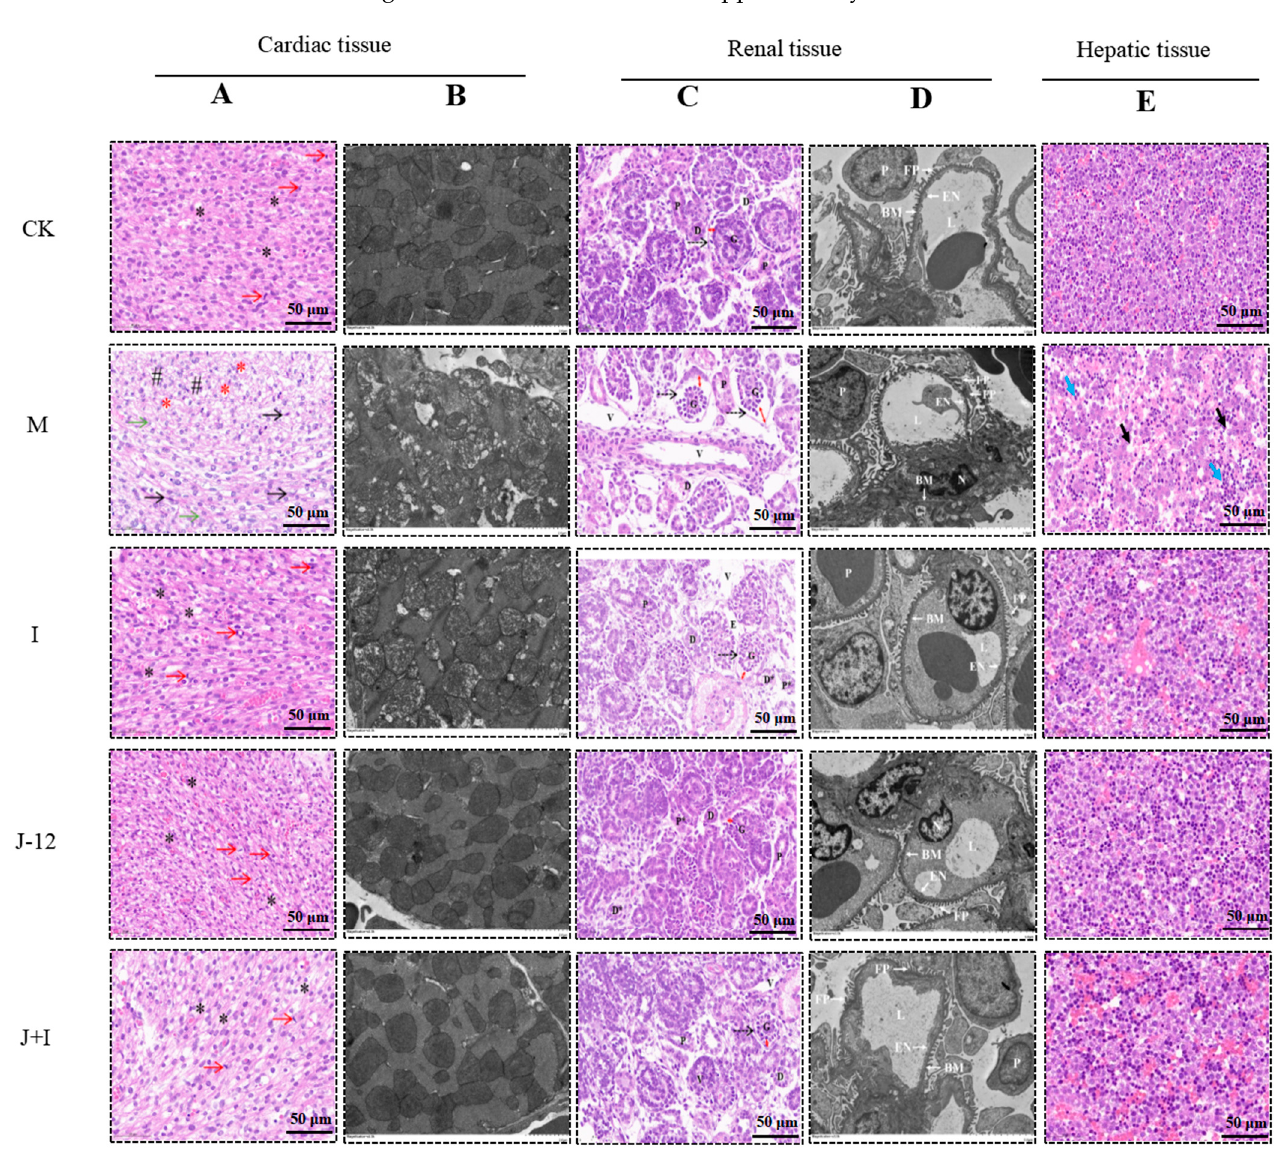
Figure 5. J-12 reduced cardiac, renal, and hepatic tissue damage of fetuses. ( A ) H&E staining in cardiac sections. Mitosis is indicated by the red arrows, and transverse band of cardiomyocytes is indicated by “*”. Cellular nuclear sequestration is indicated by the black arrow, cytoplasmic hydro- graphic changes is indicated by “#”, chromatin hydrolysis of the nucleus is indicated by the green arrows, and cytoplasmic vacuolization is indicated by the red “*”. Magnification = ×400. Scale bar: 50 μ m. ( B ) Transmission electron microscopy (TEM) in cardiac sections. Magnification = ×5.0 k. Scale bar: 2 μ m. ( C ) H&E staining in renal sections. Renal capsule is indicated by the dashed arrow, eryth- rocyte space is indicated by the double arrow. Glomerular (G), proximal convoluted tubules (P/P*), distal convoluted tubules (D/D*), tubular vacuole (V). Magnification = ×400. Scale bar: 50 μ m. ( D ) Transmission electron microscopy (TEM) in renal sections. Glomerular capillary lumen (L), endo- thelial cell with euchromatic nucleus (N), fenestrated layer (EN), basement membrane (BM), podo- cyte (P), foot processes (FP). Magnification = ×3.0 k. Scale bar: 5 μ m. ( E ) H&E staining in hepatic sections. Hepatic cord rupture is indicated by the black arrow, and relative increase of hematopoi- etic cells is indicated by the blue arrow. CK: control group, rats fed a standard diet. M: model group, rats fed an HFD and administered a single STZ injection prior to pregnancy and then fed a standard diet during pregnancy. I: insulin group, rats fed an HFD and administered a single STZ injection prior to pregnancy and then fed a standard diet and injected the insulin and during pregnancy. J- 12: J-12 group, rats fed an HFD and administered a single STZ injection prior to pregnancy and then fed a standard diet during pregnancy. Rats administered the J-12 suspension (1 × 10 9 CFU daily) by gavage during the entire experimental period. J + I: J-12 plus insulin group, rats fed an HFD and